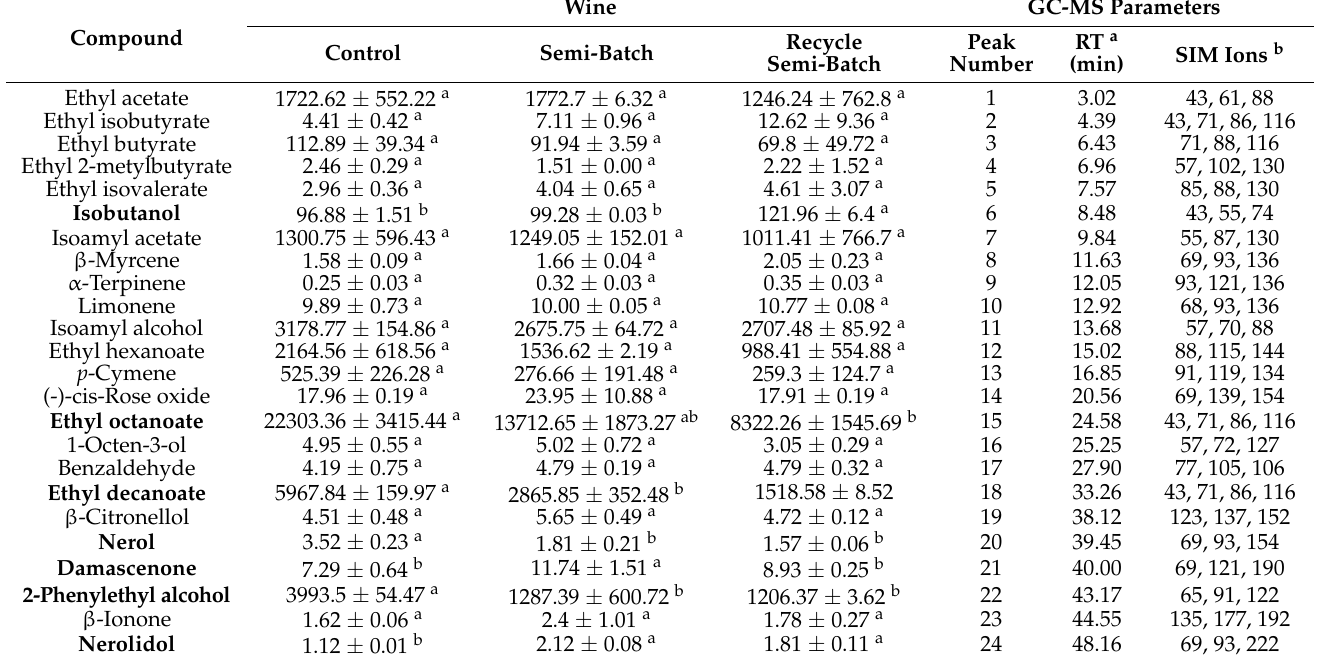
Table 3. Wine volatile compound levels and GC-MS parameters analyzed. Values are expressed as relative peak area multiplied by 1000. Bold compounds = significant different among the wines. Wine GC-MS Compound